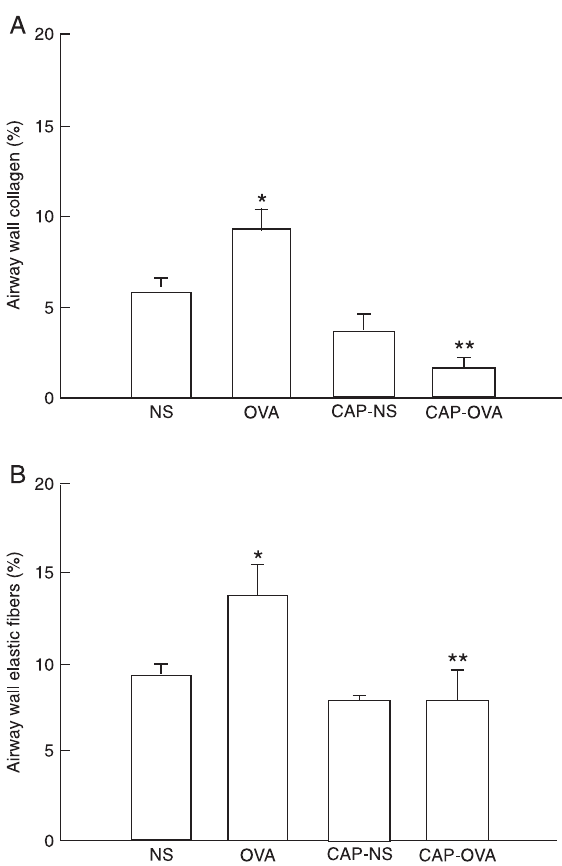
Figure 4. Airway remodeling. Data are reported as means and SEM of collagen (A) and elastic (B) content in airways reported as percentage. *P < 0.05 compared to normal saline-exposed animals (OVA x NS groups); **P < 0.01 compared to animals exposed to ovalbumin that received vehicle of capsaicin (OVA x CAP-OVA groups). Statistical analysis was done by two-way analysis of variance, and multiple comparisons were made using the Holm-Sidak method.